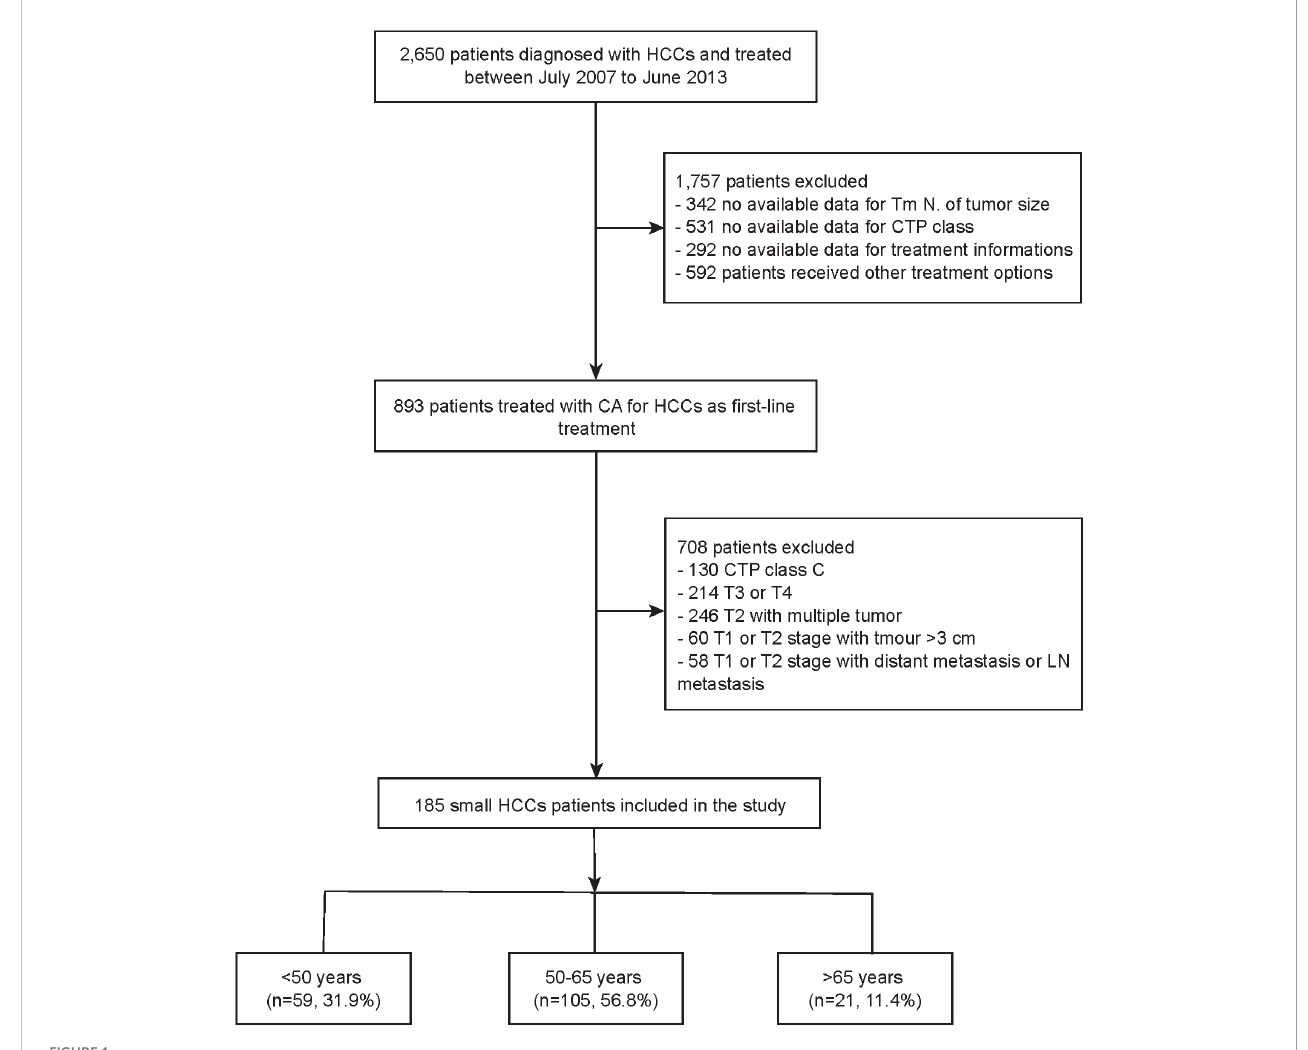
FIGURE 1 The fl owchart of enrolled